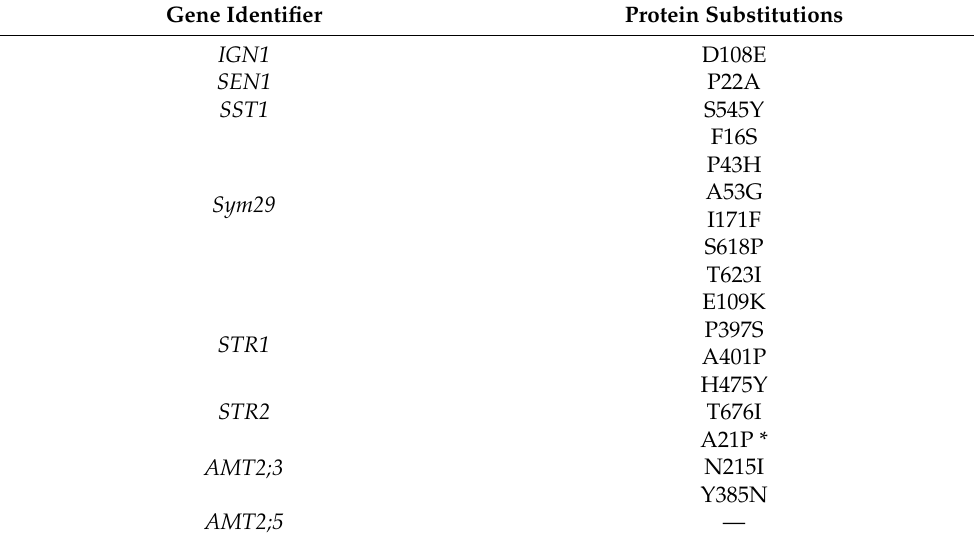
Table 4. The selected Sym genes and detected missense variations in putative protein sequences.